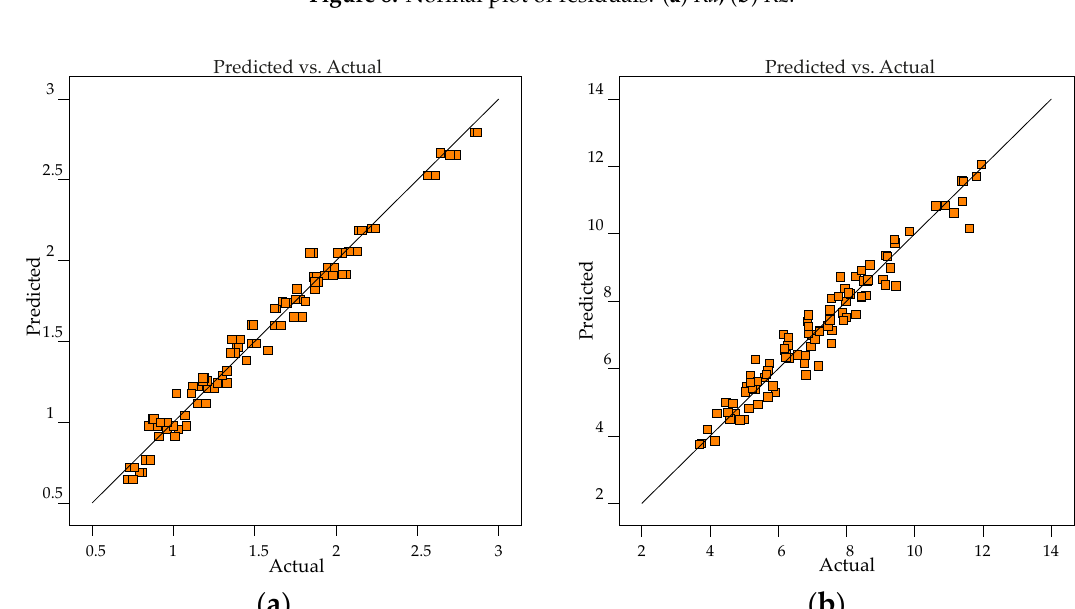
Figure 9. Predicted versus actual response values: ( a ) Ra ; ( b ) Rz .